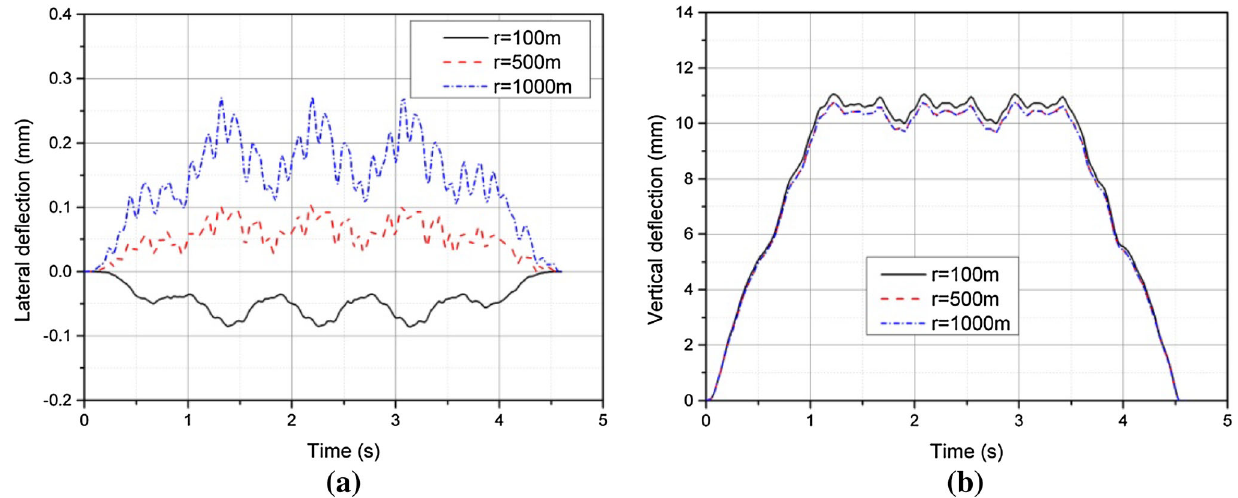
Fig. 6 Record of vibration displacement at middle span (unit: mm). a Lateral, b vertical